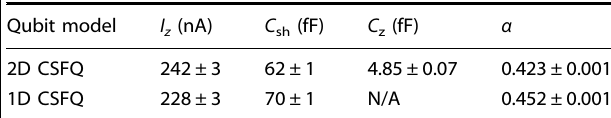
Table 2. Fit parameters and their 1 σ standard deviation for qubit models. Asymmetry is fi xed at d = 0.102 for both